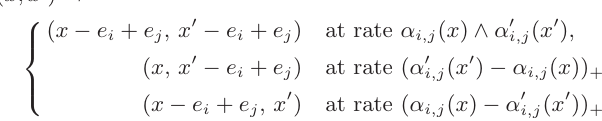
Figure 1: Open linear network with n = 3